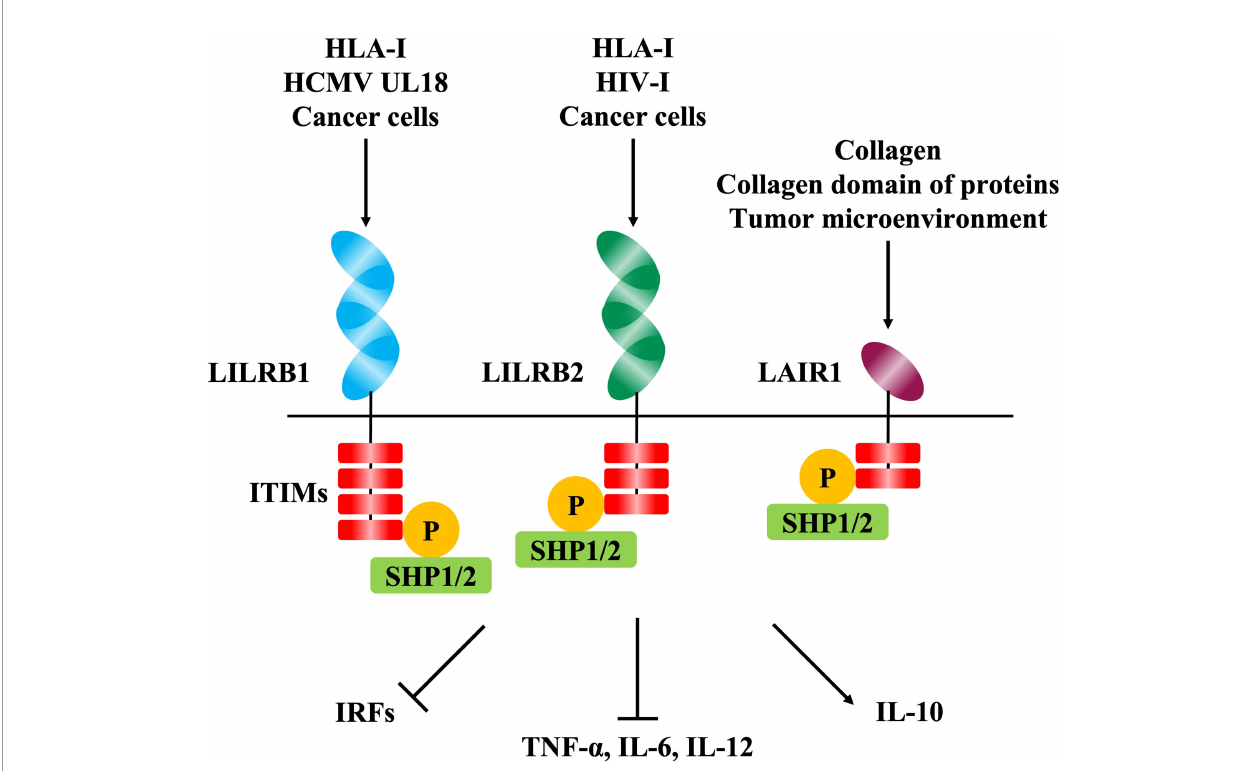
FIGURE 2 | The signaling pathways mediated by inhibitory immune receptors. The phosphorylation of immunoreceptor tyrosine-based inhibition motifs (ITIMs) in the intracellular domain is induced by the binding of ligands to the extracellular domain of inhibitory immune receptors including LILRB1, LILRB2, and LAIR1. Phosphorylation of ITIMs induces phosphatases such as SHP-1 and SHP-2, resulting in immunosuppressive effects such as decreased cytokine production via various intracellular signaling